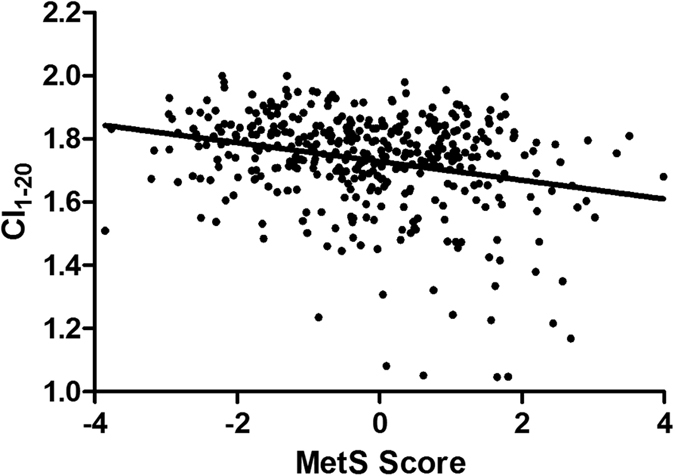
Correlation of metabolic syndrome severity, in terms of MetS Score, and complexity index (CI1–20).MetS Score = −11.8769 + (1.5432298 * Log Glucose) + (0.7872732 * Log Triglyceride) − (1.588791 * Log HDL) + (0.0277125 * WC) + (0.0232299 * SBP) + (0.0420722 * DBP) − (0.016408 * Age) − (0.73821 * Gender) Male = 1, Female = 0. p < 0.001.